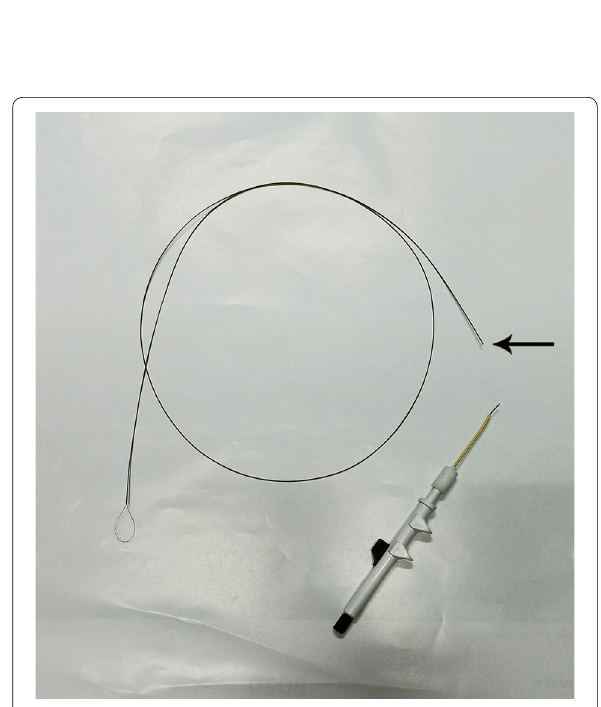
Fig. 4 After cutting the basket proximally, the basket can be held by the assistant (shown by arrow mark) and stone can be fragmented with laser. After stone clearance the basket can be retrieved by gentle hand